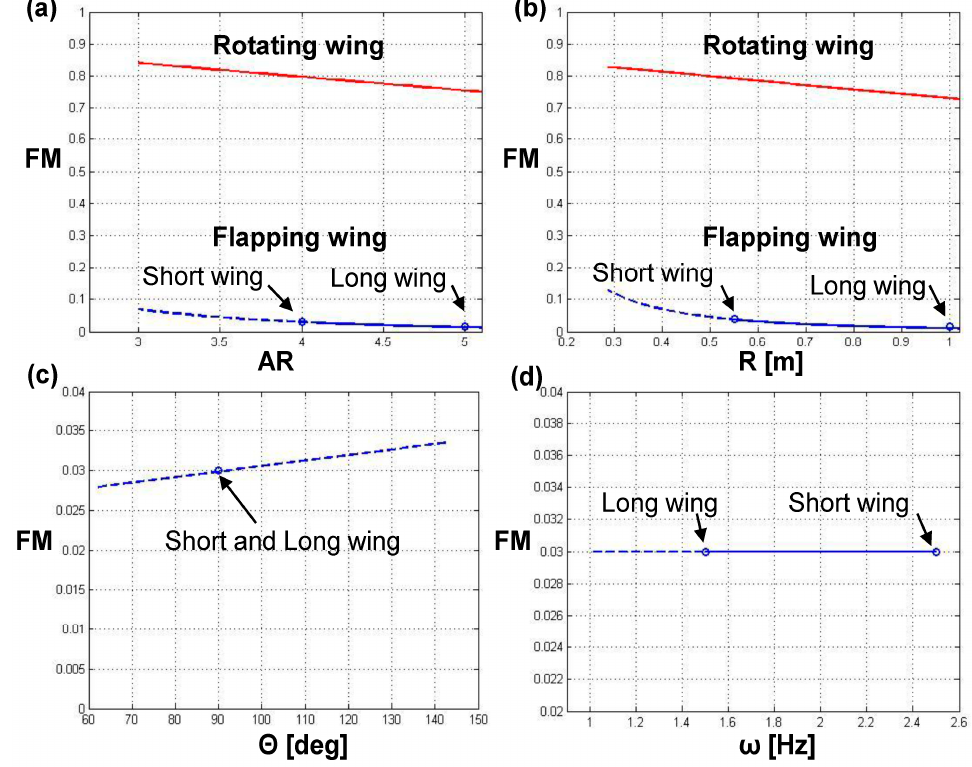
Figure 20. Figure of merit (FM) of rotating and flapping wings as a function of: ( a ) aspect ratio; ( b ) wing span; ( c ) stroke amplitude; ( d ) flapping frequency. The fixed parameters are: Flapping frequency of 1.5 Hz, AOA 5°, wing span 1.1 m, stroke amplitude 90°. The dashed lines represent extrapolation.